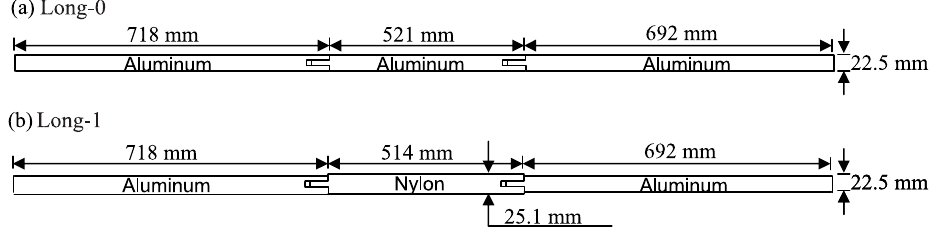
Fig. 3. Two different layer con fi gurations of the long structure and their dimensions used in the experiments; (a) all three parts are made of aluminum, (b) two ends are made of aluminum and the center part is made of nylon. material, three different layer con fi gurations are built. The fi rst con fi guration, ‘Short-0’, is made of all aluminum parts. The second con fi guration, ‘Short-2’, has one layer made of two polycarbonate rings (double length) at the middle of the structure. Finally, the last con fi guration, ‘Short-3’, has two layers of polycarbonate between